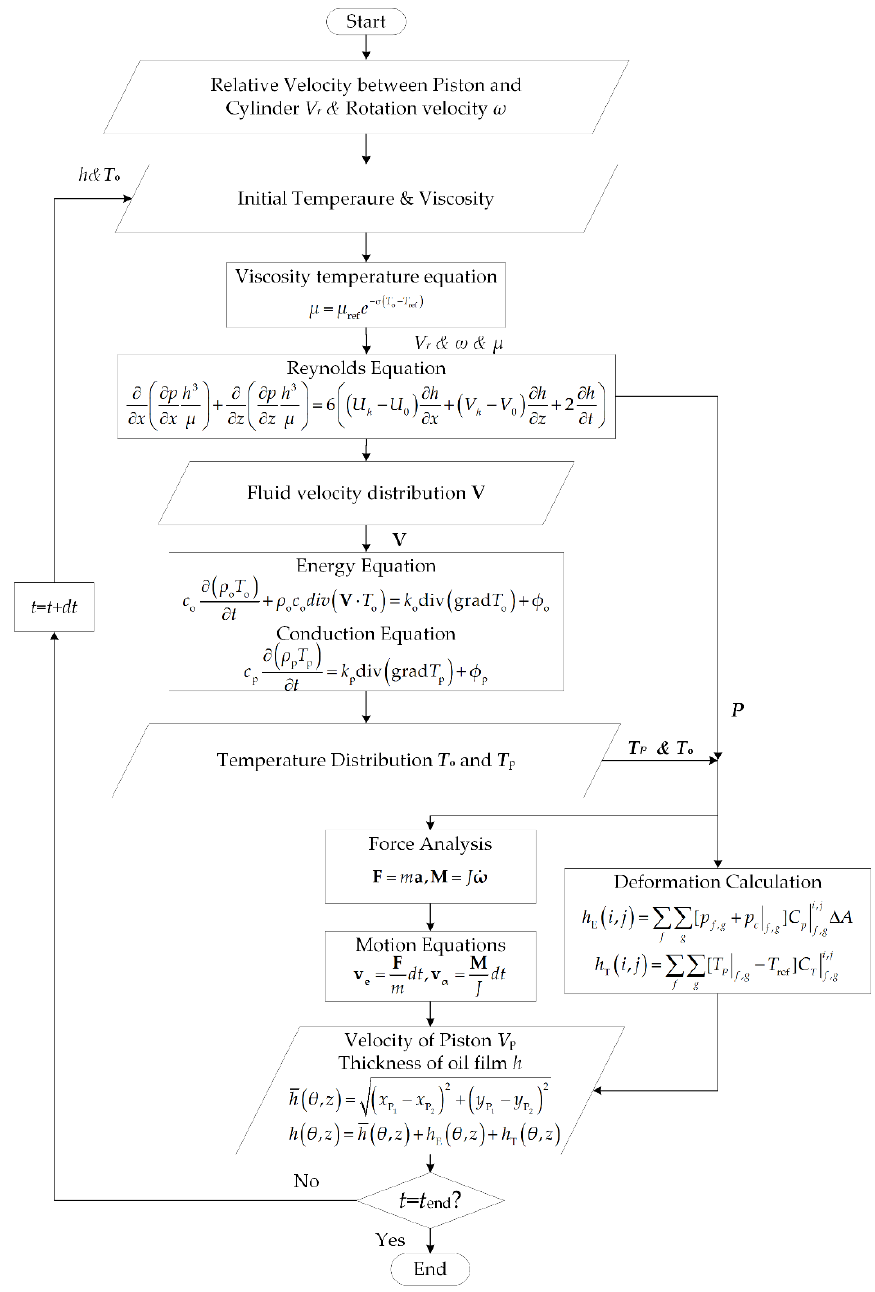
F igure 7. Flow chart of calculation. Figure 7. Flow chart of